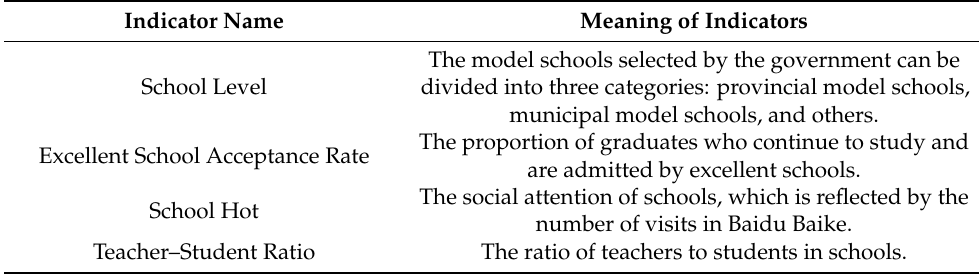
Table 1. Calculation indicators of school education